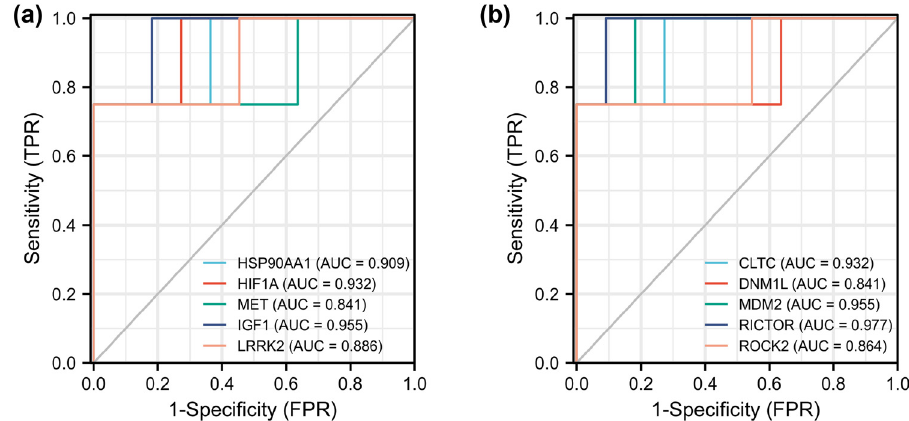
Figure 7: ROC analysis of ten hub genes: ( a ) the ROC curves of HSP90AA1, HIF1A, MET, IGF1, and LRRK2 in the diagnosis of PAH and ( b ) the ROC curves of CLTC, DNM1L, MDM2, RICTOR, and ROCK2 in the diagnosis of